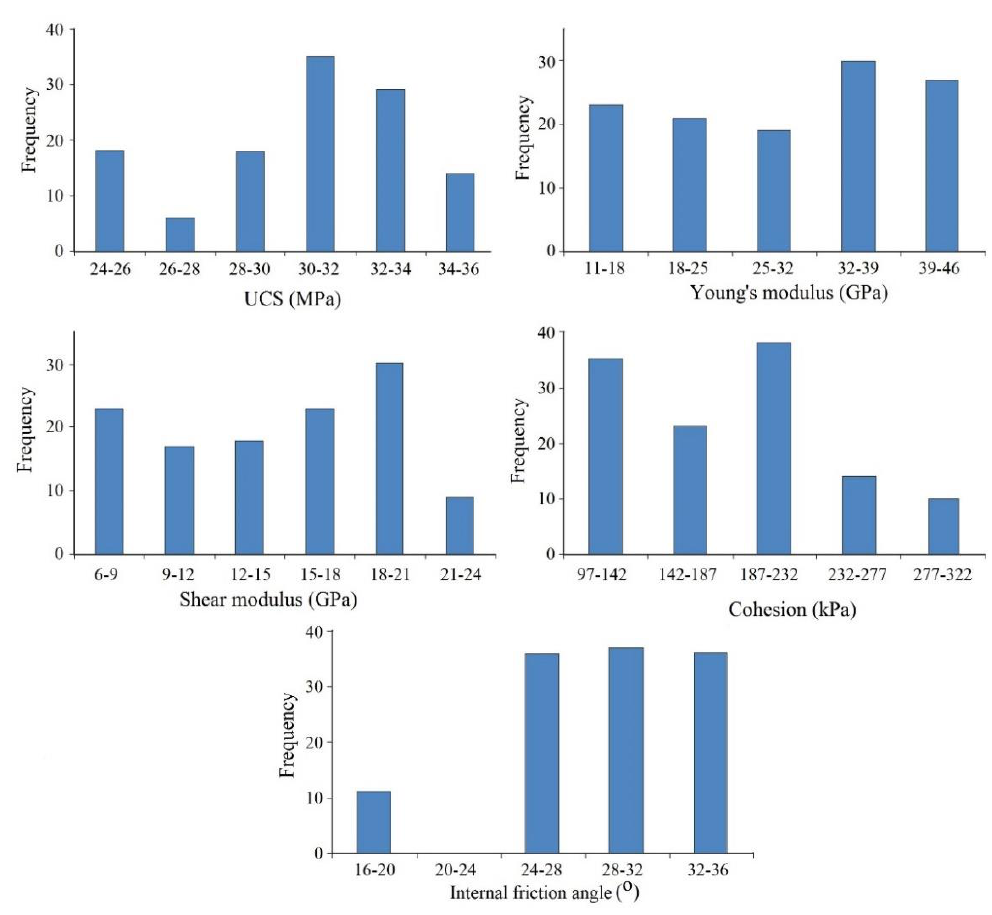
Figure 2. A histogram of the geomechanical indices. Table 1. Sedimentary rock classification system by Pettijohn